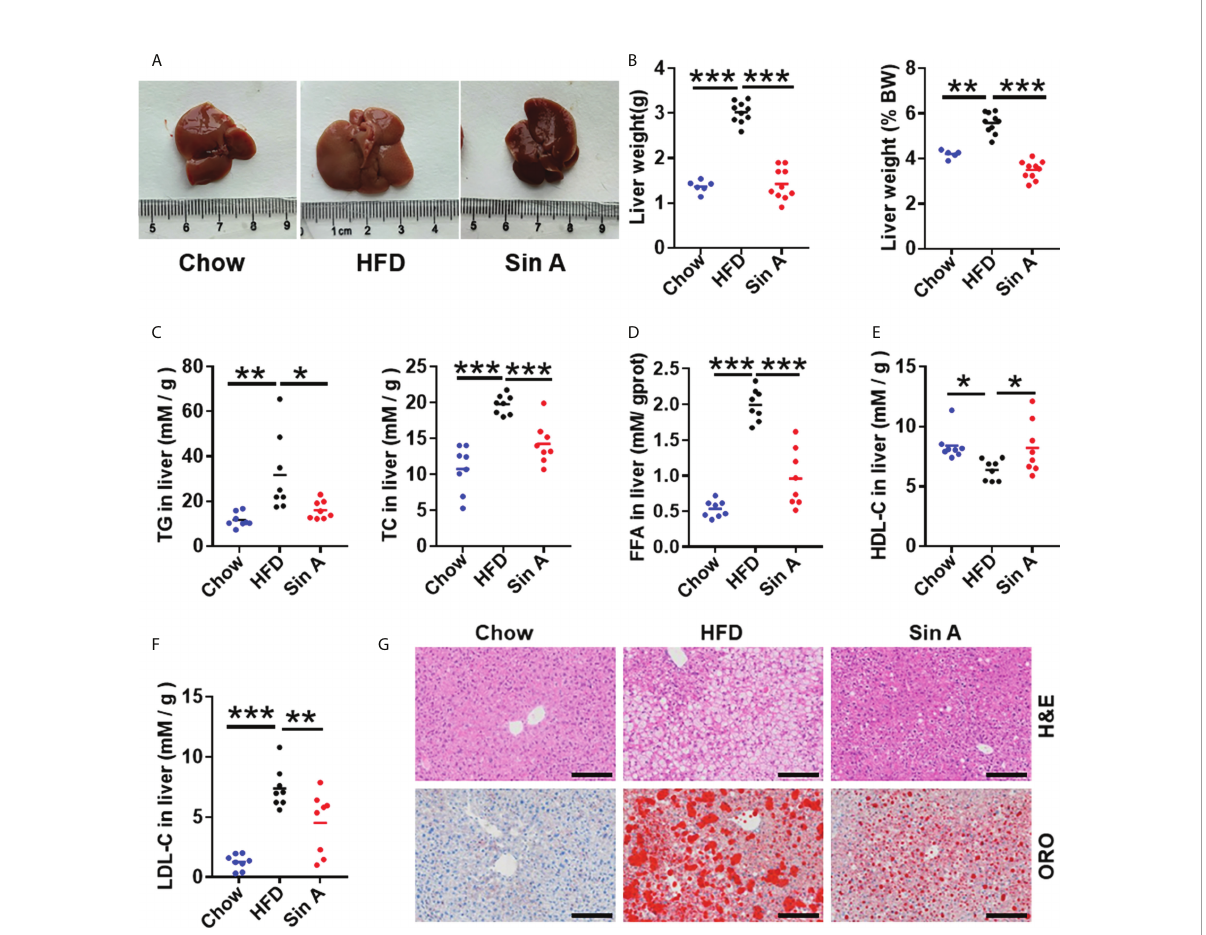
FIGURE 1 Sin A attenuates hepatic steatosis in HFD-fed mice. Mice were randomly divided into three groups ( n =8 – 10). Chow diet-fed mice were orally treated with normal diet (chow). HFD-fed mice were orally treated with vehicle (HFD) or Sin A (80 mg/kg) for 6 weeks. (A) Representative images of liver from chow, HFD, and Sin A groups. (B) The result of liver weight and the ratio of liver-to-body weight (BW) ( n =6 – 10 per group). (C) The changes in hepatic triglycerides (TG) and total cholesterol (TC) ( n =8 per group). (D) Free fatty acids (FFAs) contents of liver fraction ( n =8 per group). (E,F) Changes in liver HDL-C, LDL-C level. (G) Representative images of H&E staining and Oil Red O staining of liver. Scale bars 100 m m. Values represent mean ± SD. Signi fi cant differences were determined by one-way ANOVA for multiple- group comparisons. p